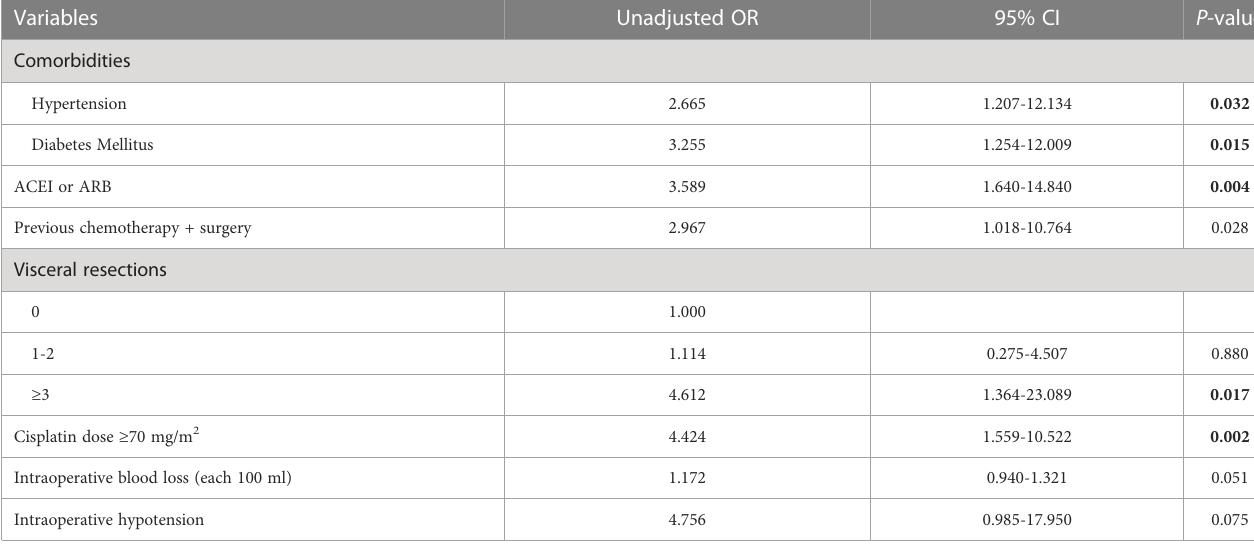
TABLE 2 Univariate analysis of risk factors for AKI after CRS plus